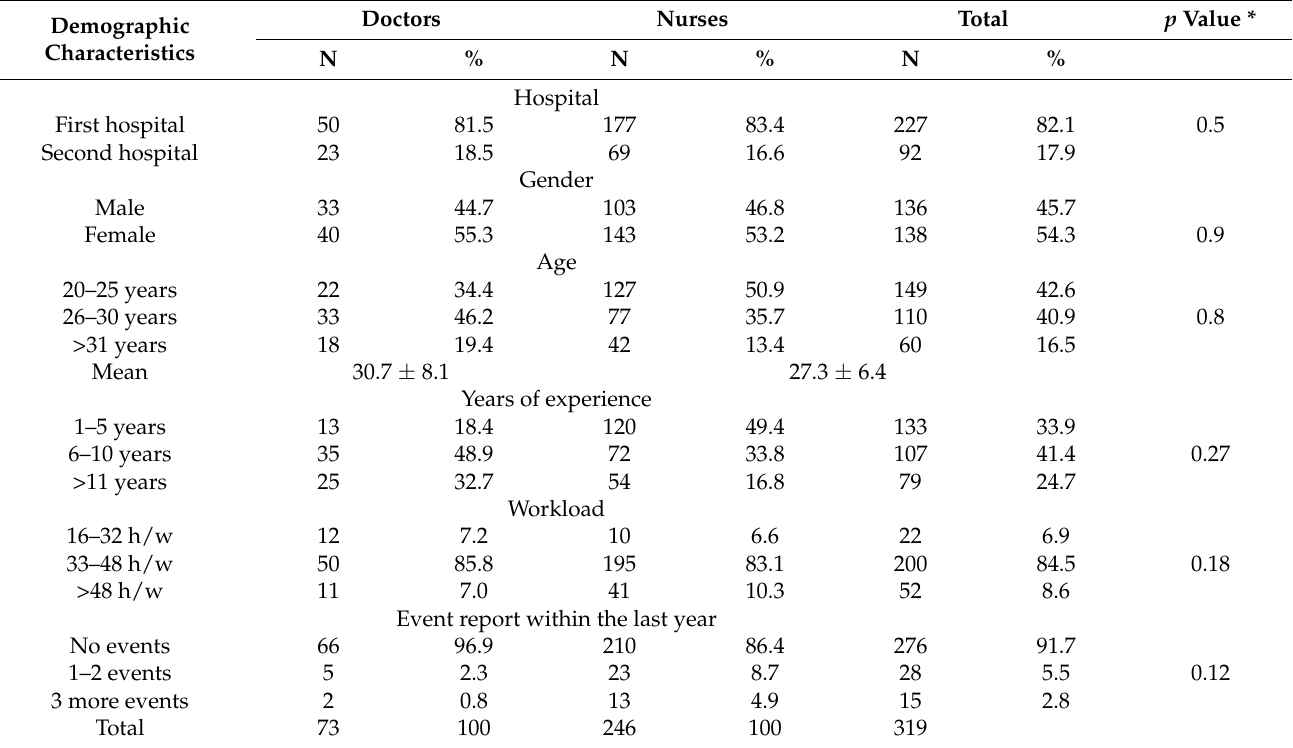
Table 1. Demographic Characteristics of the Participants (N =